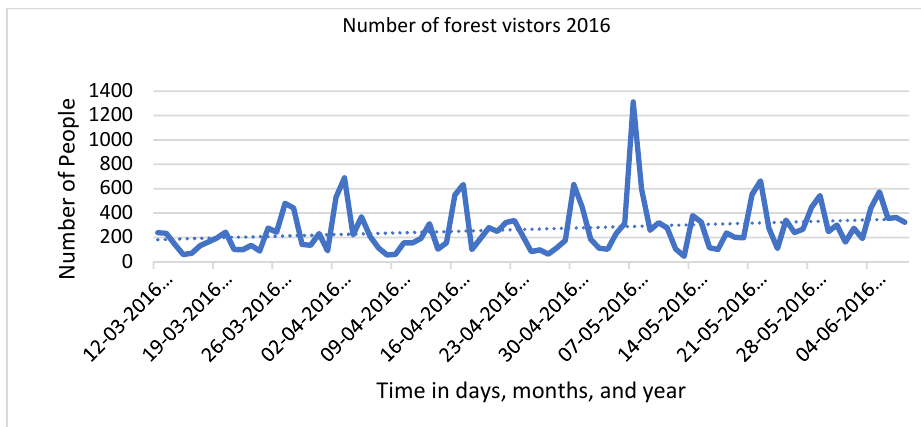
Figure A2. Recorded number of visitors per day in three months in 2016.